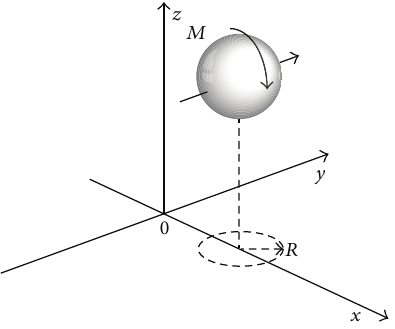
Figure 6: Example I: a rolling sphere with collision and slip. In the simulation, the parameters are chosen as 𝑀 = 1 kg, 𝑅 = 0.5 m, and 𝜇 = 0.1 and the initial conditions are ̇𝑝 = [5.5, 0, 0] 𝑇 m/s, 𝑝 = [0, 0,2𝑅] 𝑇 , and 𝜔 = [0,0, 0] 𝑇 rad/s.